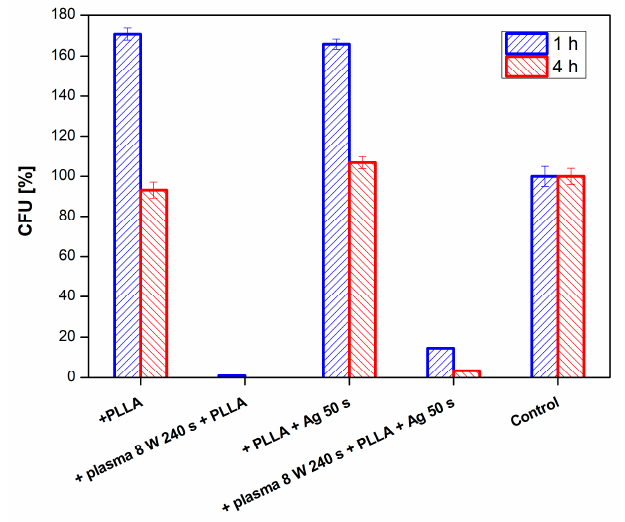
Figure 14. Results of antimicrobial tests for PTFE + PLLA using bacterial strain S. aureus for samples modified by plasma at 8 W for 240 s, and sputtered with Ag for 50 s.